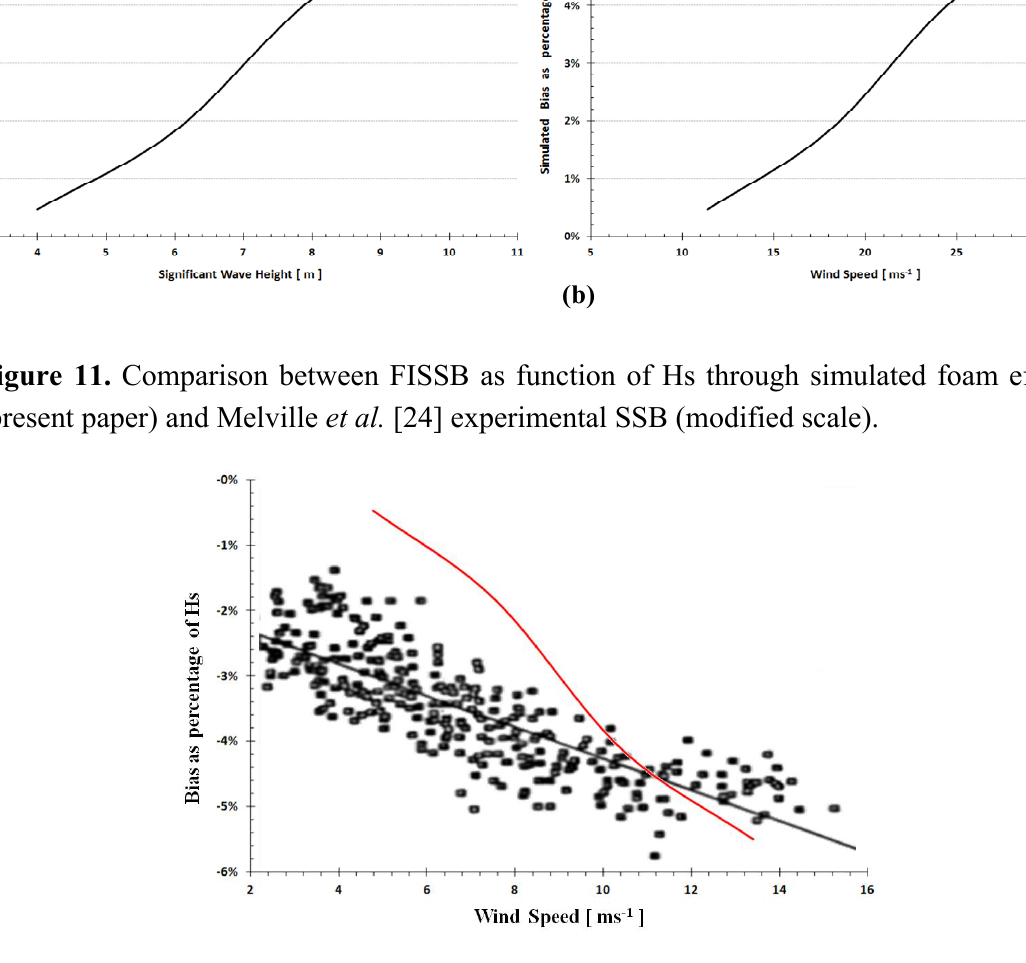
Figure 10. Simulated Sea State Bias SSB as function of H SSB is expressed as a percentage of H